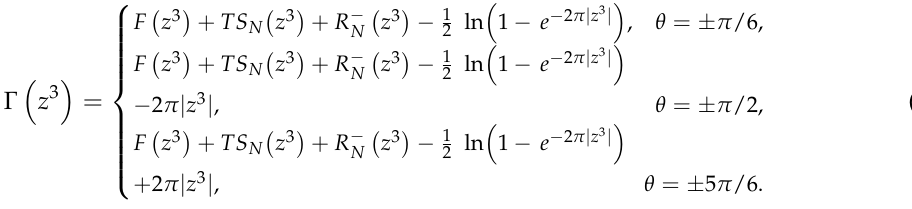
Table 8. ln Γ ( z 3 ) for